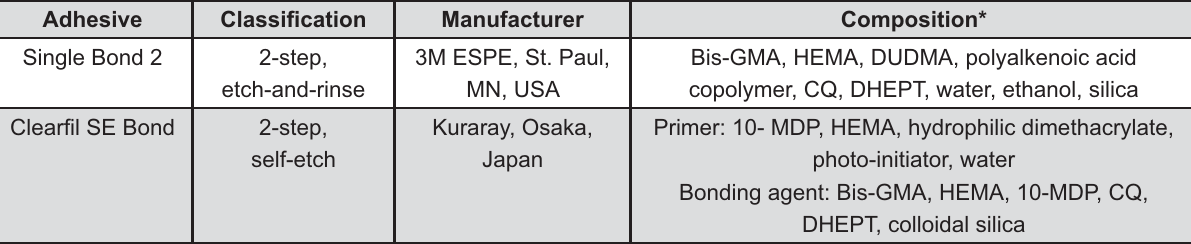
Figure 1- (cid:8)(cid:2)(cid:3)(cid:5)(cid:15)(cid:15)(cid:16)(cid:7)(cid:17)(cid:5)(cid:18)(cid:16)(cid:12)(cid:13)(cid:19)(cid:8)(cid:20)(cid:5)(cid:13)(cid:21)(cid:22)(cid:5)(cid:17)(cid:18)(cid:21)(cid:6)(cid:4)(cid:6)(cid:8)(cid:5)(cid:13)(cid:14)(cid:8)(cid:17)(cid:12)(cid:20)(cid:23)(cid:12)(cid:15)(cid:16)(cid:18)(cid:16)(cid:12)(cid:13)(cid:8)(cid:12)(cid:22)(cid:8)(cid:18)(cid:24)(cid:4)(cid:8)(cid:5)(cid:14)(cid:24)(cid:4)(cid:15)(cid:16)(cid:25)(cid:4)(cid:8)(cid:5)(cid:26)(cid:4)(cid:13)(cid:18)(cid:15)(cid:8)(cid:21)(cid:15)(cid:4)(cid:14)(cid:8)(cid:16)(cid:13)(cid:8)(cid:18)(cid:24)(cid:4)(cid:8)(cid:15)(cid:18)(cid:21)(cid:14)(cid:27)(cid:28)(cid:8)(cid:29)(cid:30)(cid:15)(cid:8)(cid:16)(cid:13)(cid:22)(cid:12)(cid:6)(cid:20)(cid:4)(cid:14)(cid:8)(cid:31)(cid:27)(cid:8)(cid:18)(cid:24)(cid:4)(cid:8) manufacturers. Bis-GMA: bisphenol-A glycidyl dimethacrylate; HEMA: 2-hydroxyethyl methacrylate; DUDMA: diurethane dimethacrylate; CQ: camphorquinone; DHEPT: dihydroxyethyl p-toluidine; 10-MDP: 10-methacryloyloxydecyl